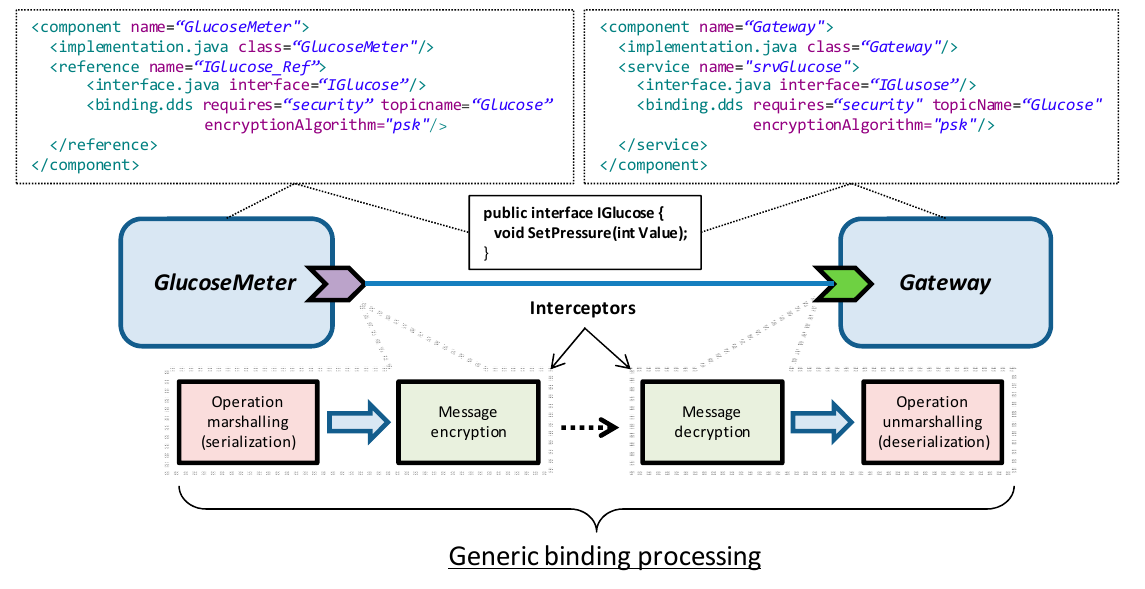
Figure 9 . SCA binding processing chain. Figure 9. SCA binding processing